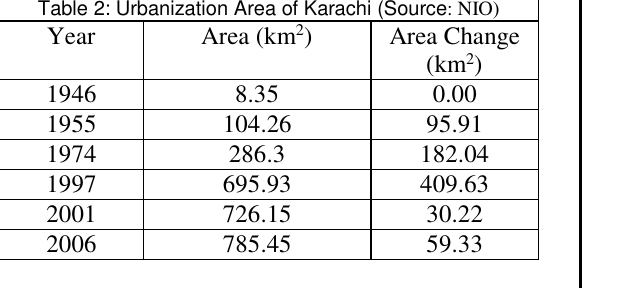
Fig. 2: Urbanization patterns of Karachi (Source: Table 2: Urbanization Area of Karachi (Source : NIO) Table 3: Change in Green Area of Karachi (Source: Forest Department of Sindh)